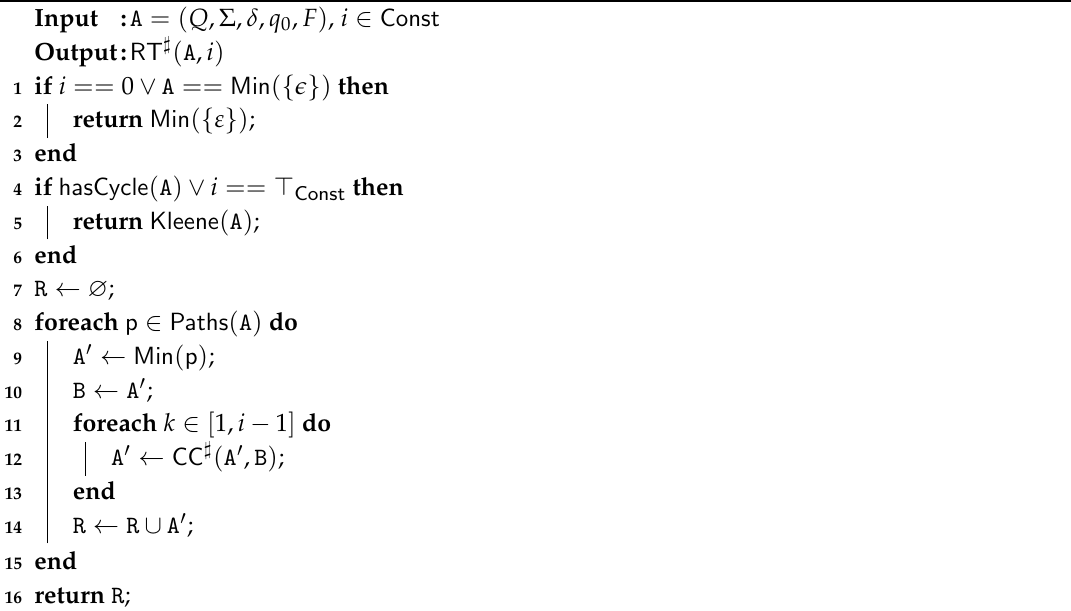
Algorithm 5: RT (cid:93) : D FA / ≡ × Const → D FA / ≡ algorithm